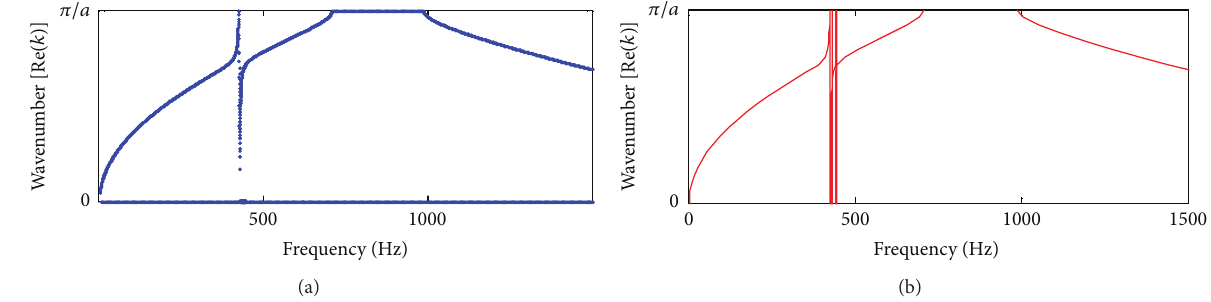
Figure 3: Dispersion relation of the one-dimensional PPC-C calculated by (a) Transfer Matrix method and (b) PWE-PPC-C, where 𝑎 = = 0 , and 𝐿 = 0.419 H. 80 mm, 𝑅 𝐿